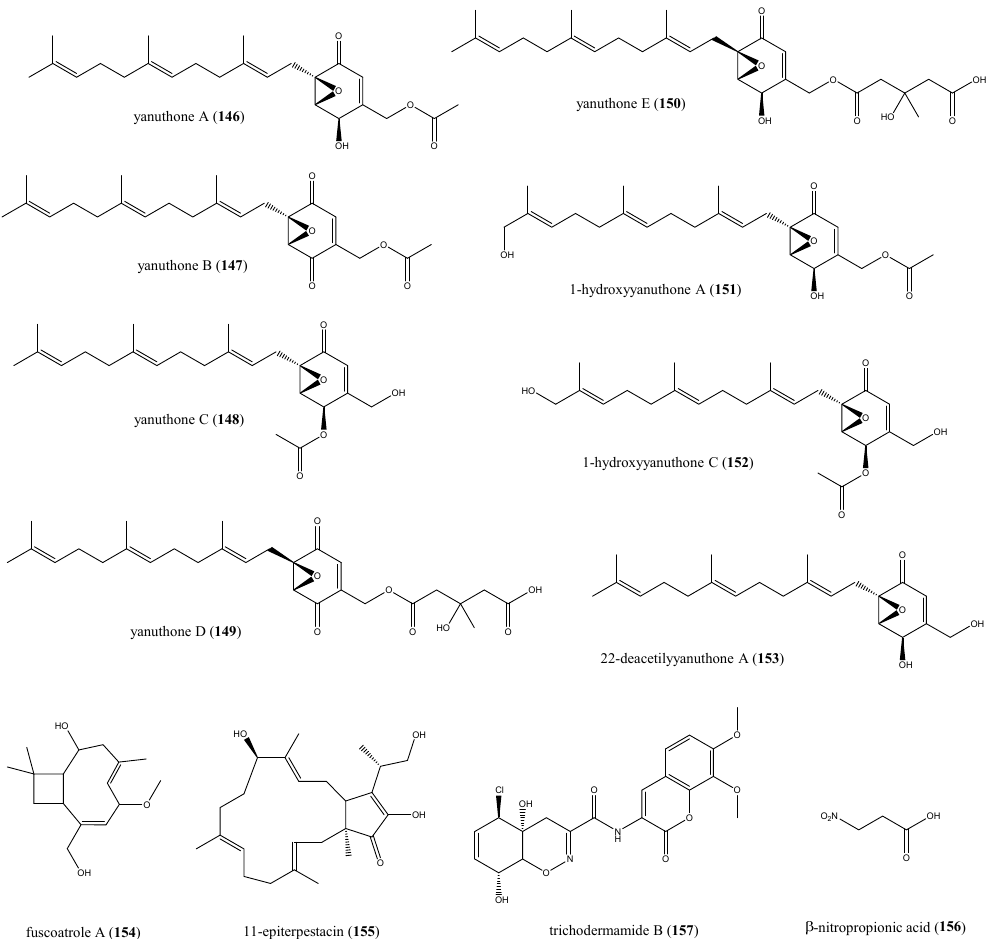
Figure 15. Structures of compounds 146 – 157 derived from ascidian-associated fungi.